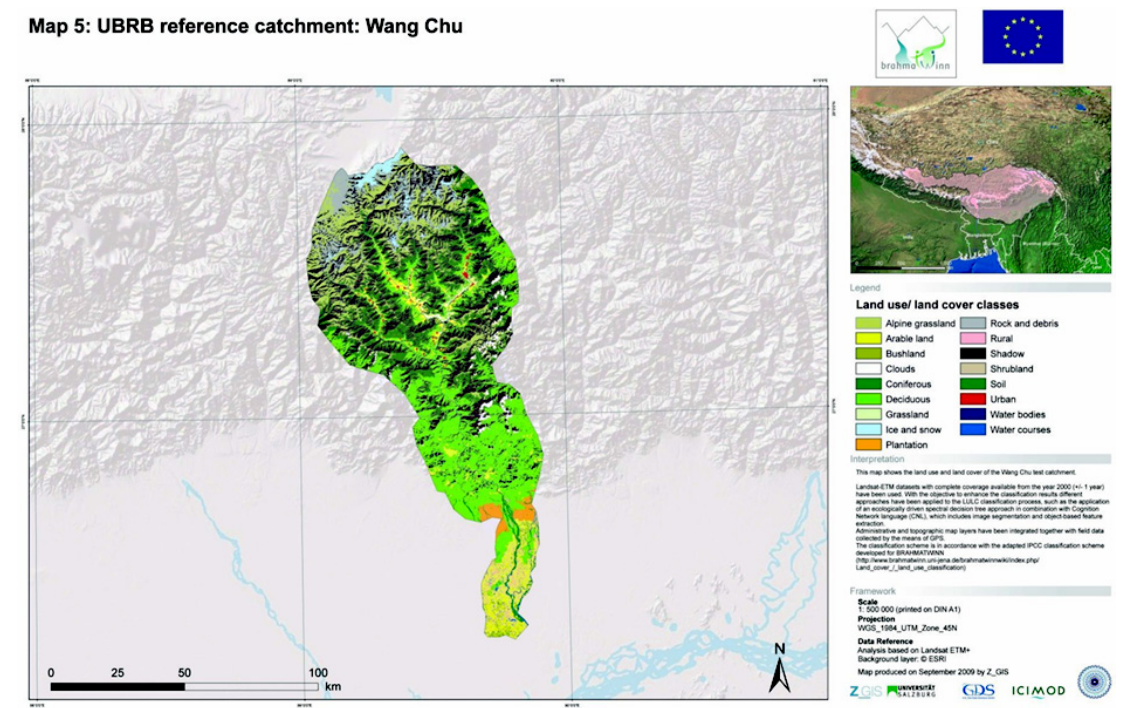
Figure 7. Land use / land cover classification for the Wang Chu river basin (Bhutan).